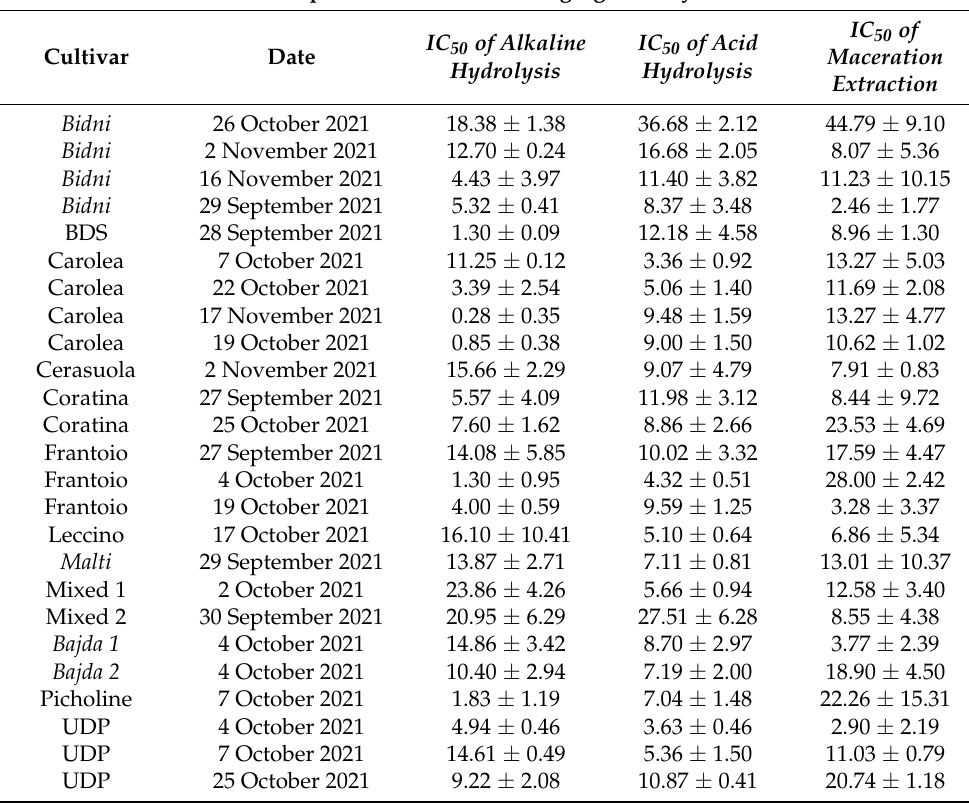
Table 3. IC 50 s of olive oil extracts for Superoxide Radical Scavenging activity assays. (BDS—Bella di Spagnaand UDP—Uovo di